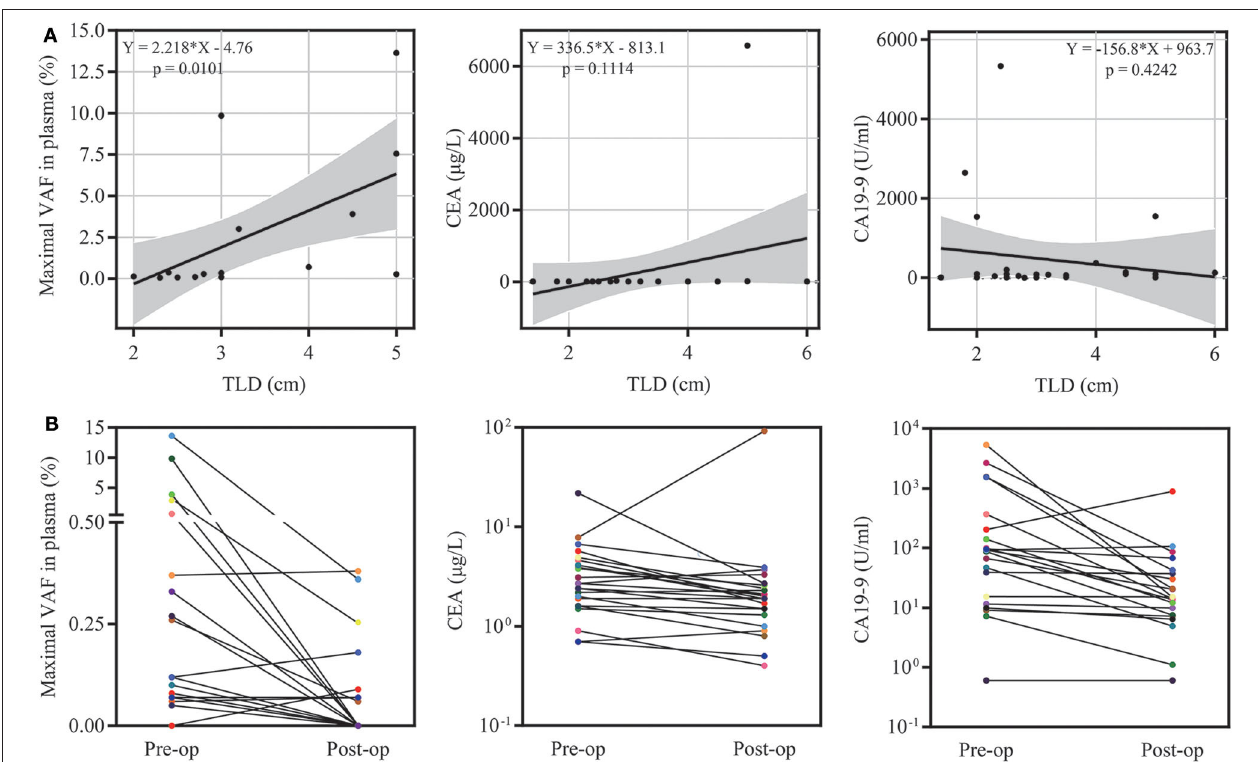
FIGURE 2 | ctDNA burden and clinical feature analysis. (A) The relationship of the maximal variant allele fraction (VAF), CEA, CA19-9 and tumor largest diameter (TLD). (B) Dynamic changes in the maximal VAF, CEA and CA19-9 7 days after surgery.